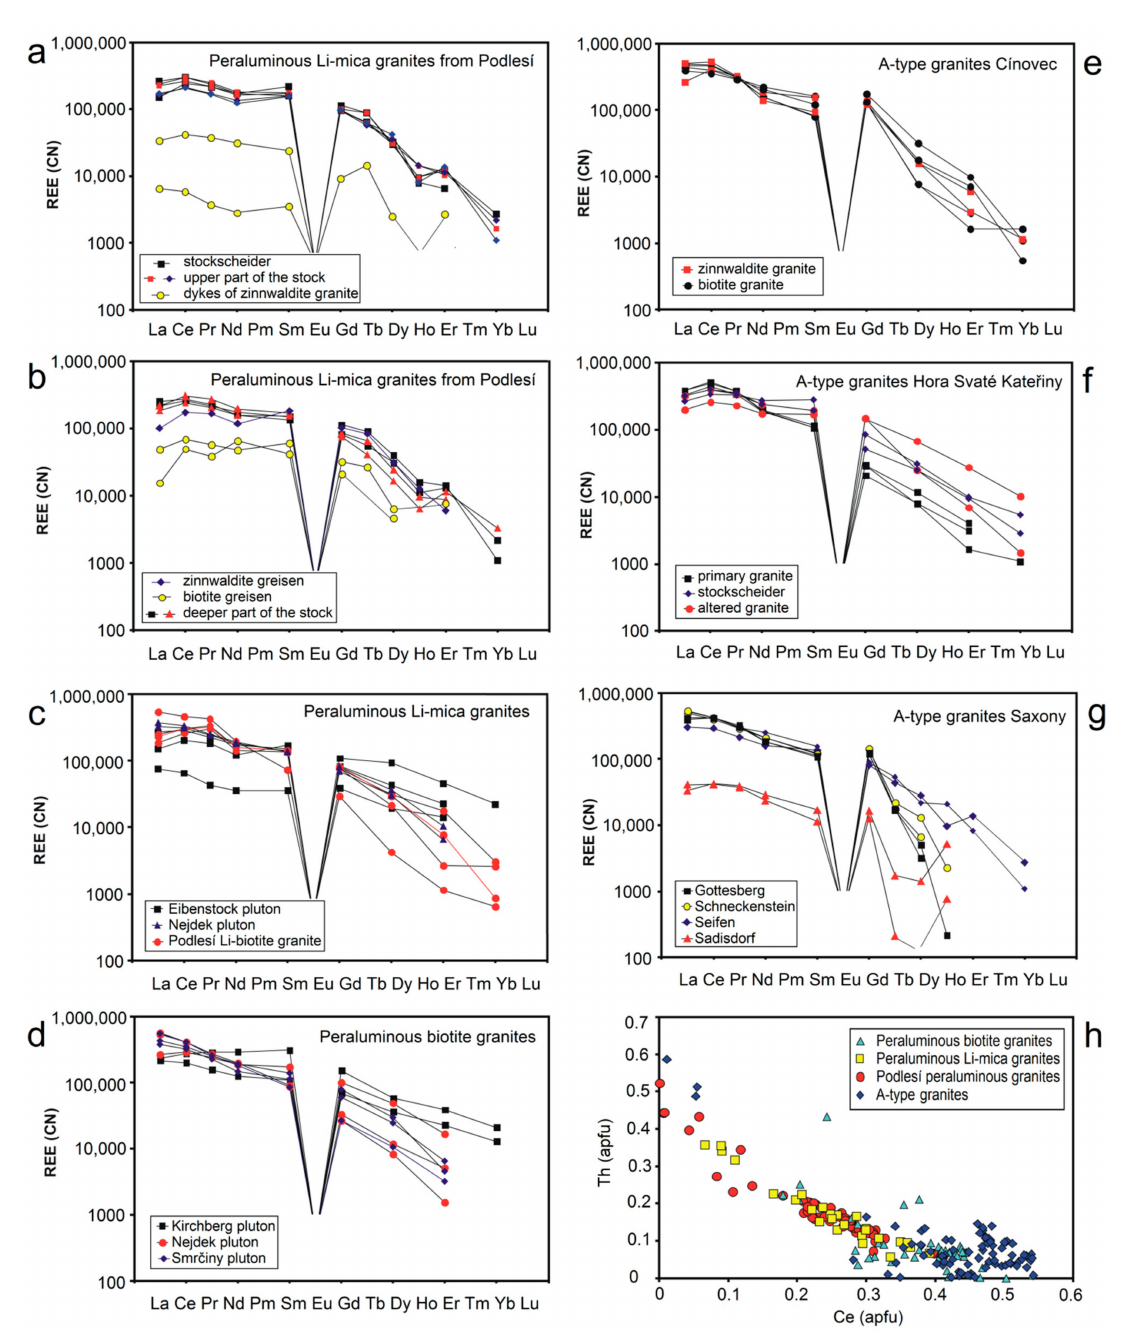
Figure 5. Chondrite-normalized [26] rare earth element (REE) distribution patterns and Th contents in monazite from the Erzgebirge: ( a – d ) REE patterns of monazite from the peraluminous suite; ( e – g ) REE patterns of monazite from the A-suite; ( h ) Ce vs. Th in monazite from all types of